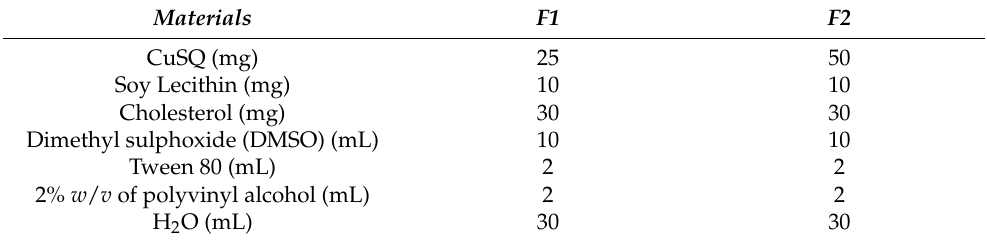
Table 6. Composition for formulations of different CuSQ ‐ loaded solid lipid nanoparticles (SLNs).